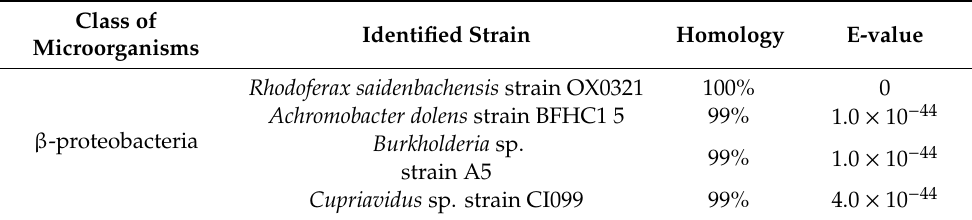
Table 5. The Results of Sequence Alignments for Samples with MCPA, SE and